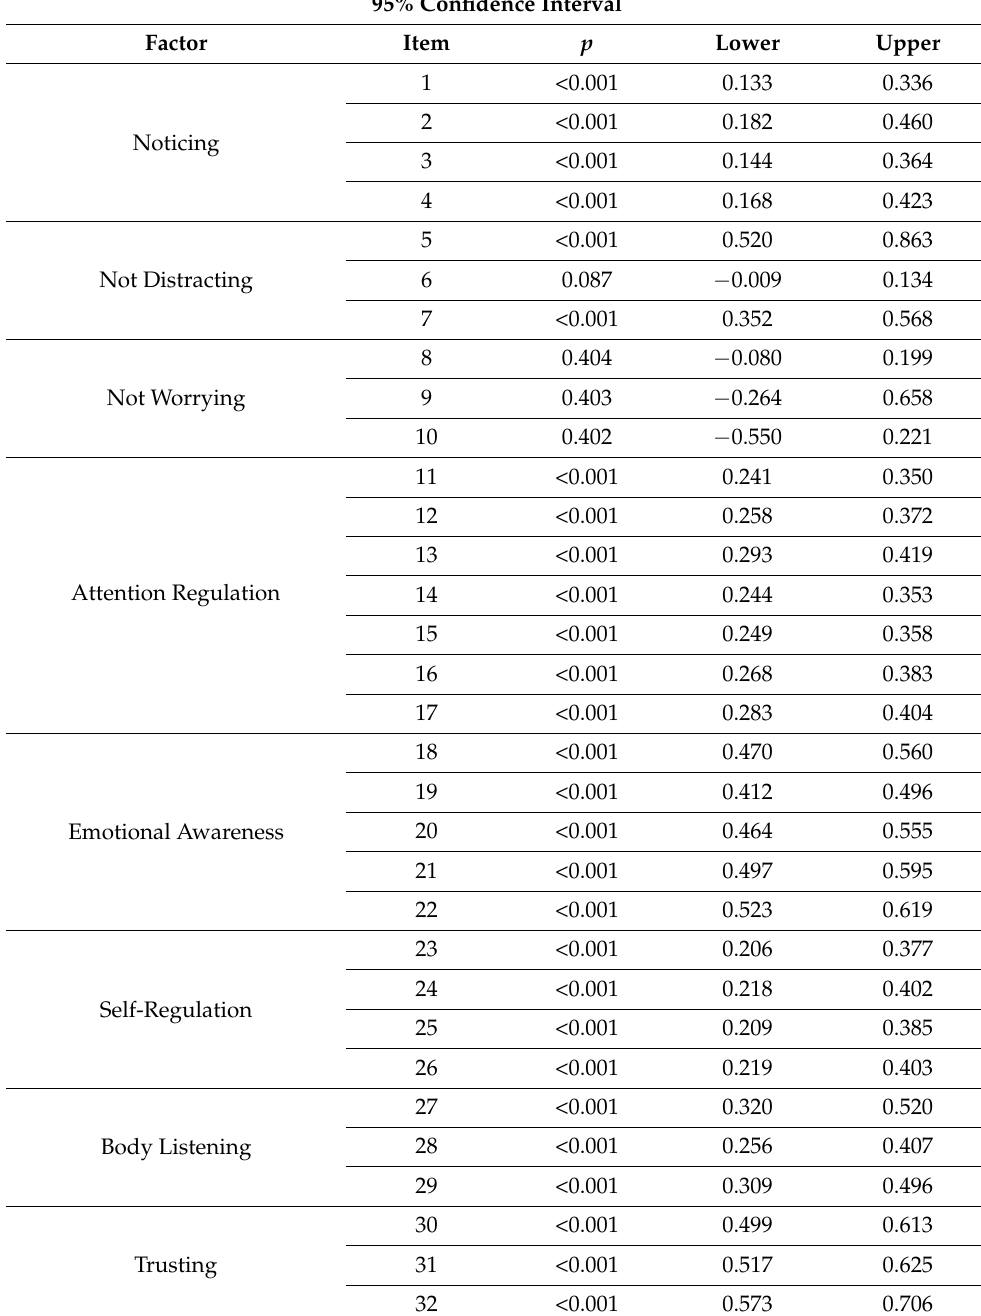
Table 7. Factor loadings of